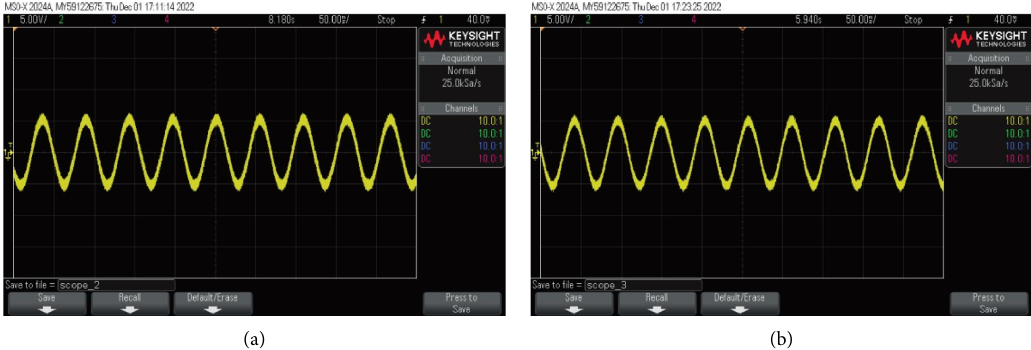
Figure 17: Experimental test results during steady-state operation: (a) winding current of phase a ; (b) winding current of phase x